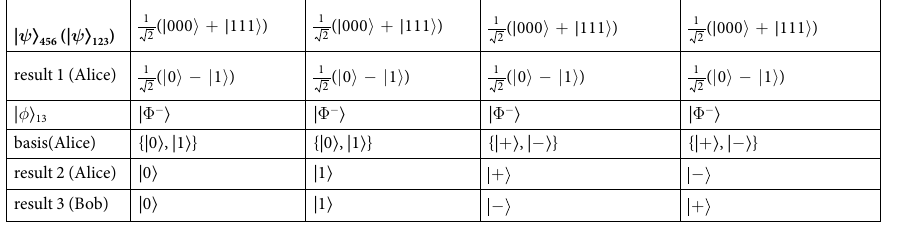
(|0 〉 + |1 〉 ), | − 〉 = 1 (|0 〉 − |1 〉 )} represents the + 2 2